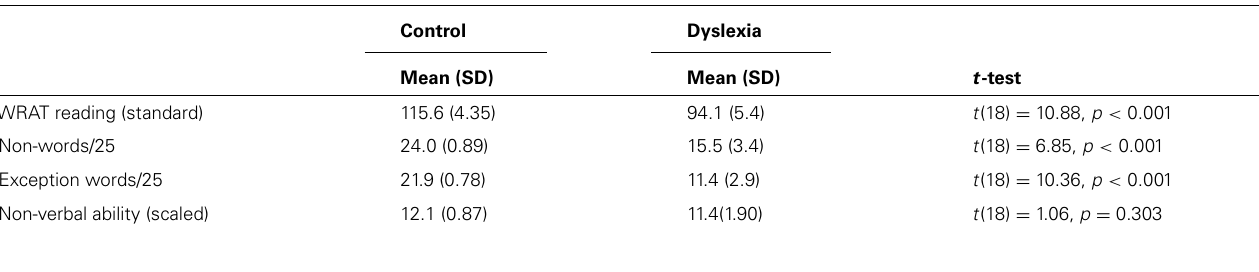
Table 2 | Performance of the control ( n = 10) and dyslexia ( n = 10) groups on the reading measures. Experiment 2.